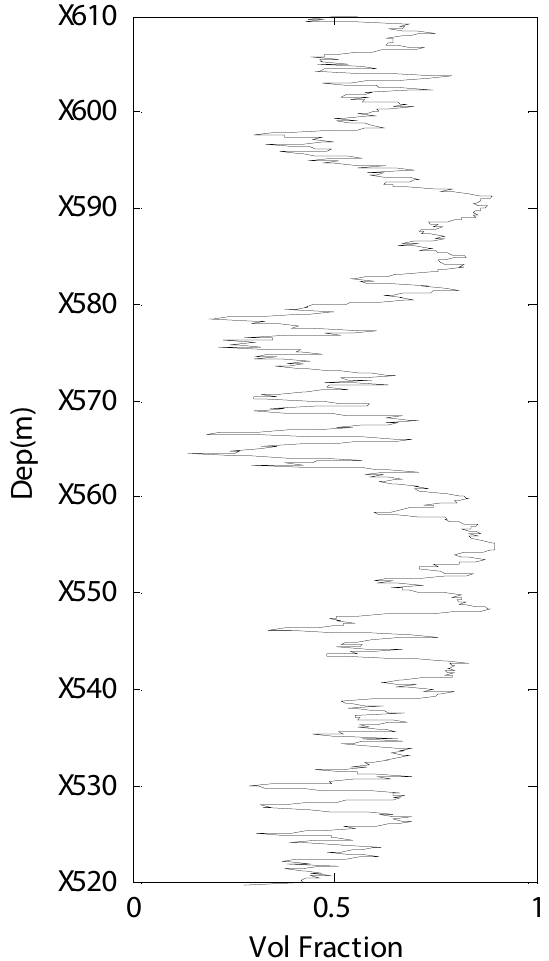
Figure 5. Volume fraction of layered kerogen with respect to the total kerogen